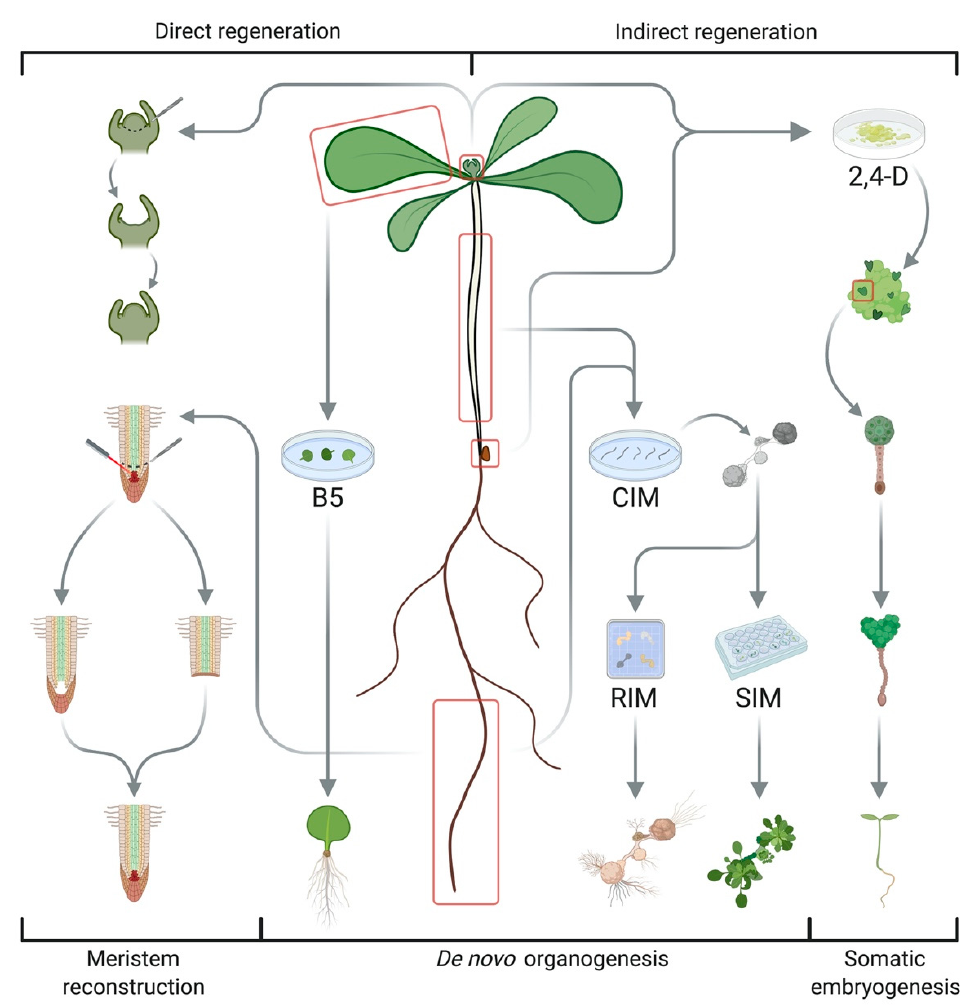
Figure 1. Diagram of key regeneration systems in Arabidopsis thaliana , including the reconstruction of shoot or root apical meristems after excision or laser ablation, adventitious rooting from excised leaves or cotyledons, de novo shoot or root organogenesis from root or hypocotyl explants, and somatic embryogenesis from immature zygotic embryos or shoot apices. This illustration was created with BioRender.com.